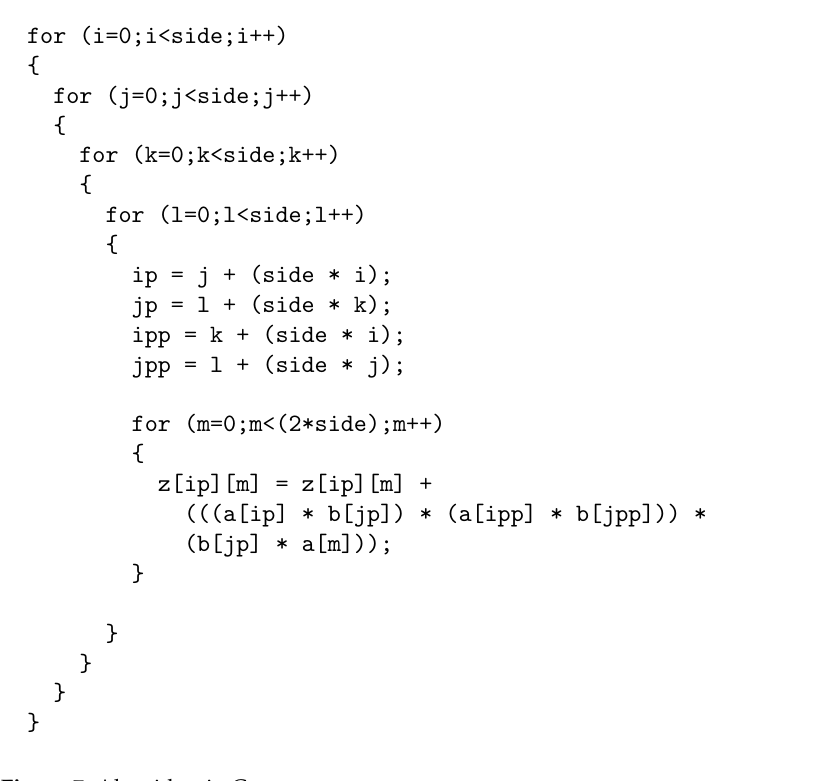
Figure 7. Algorithm in C.